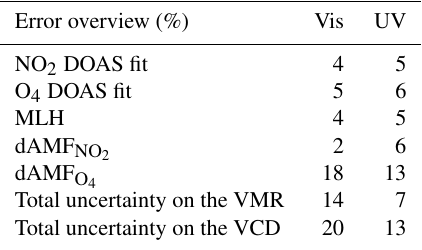
Table 5. Error budget overview of the parameterized NO 2 VMR in the visible and UV spectral ranges.